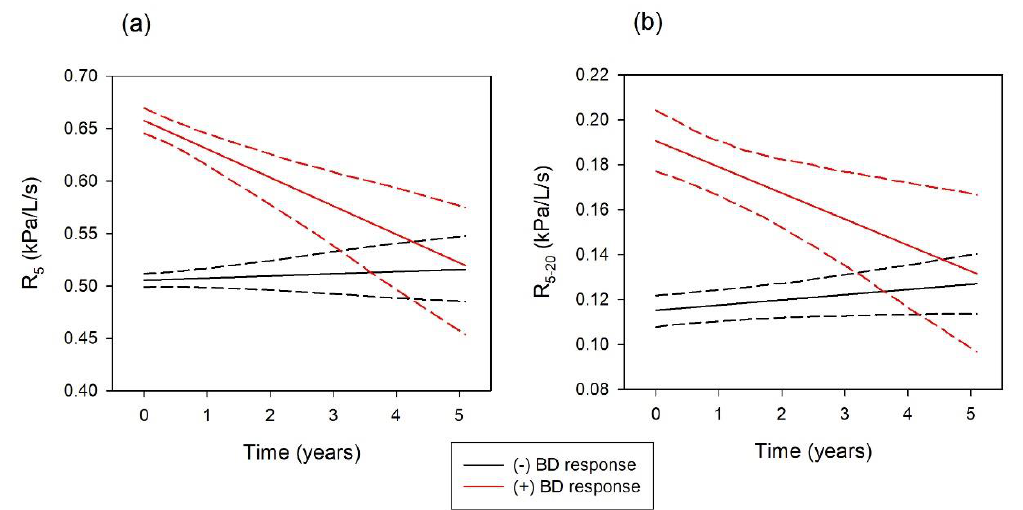
Figure 1. Panel ( a ) Longitudinal values and confidence interval for R 5 derived from mixed-effects modelling for the (−) BD and (+) BD groups. Panel ( b ) Longitudinal values and confidence interval for R 5–20 derived from mixed-effects modelling for the (−) BD and (+) BD groups.